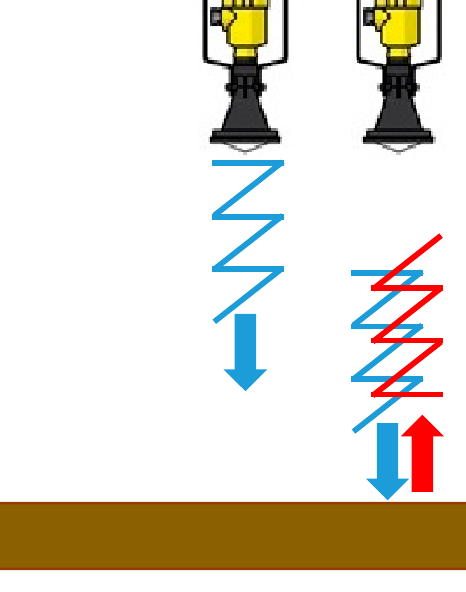
Figure 3. Function of a non-invasive radar.